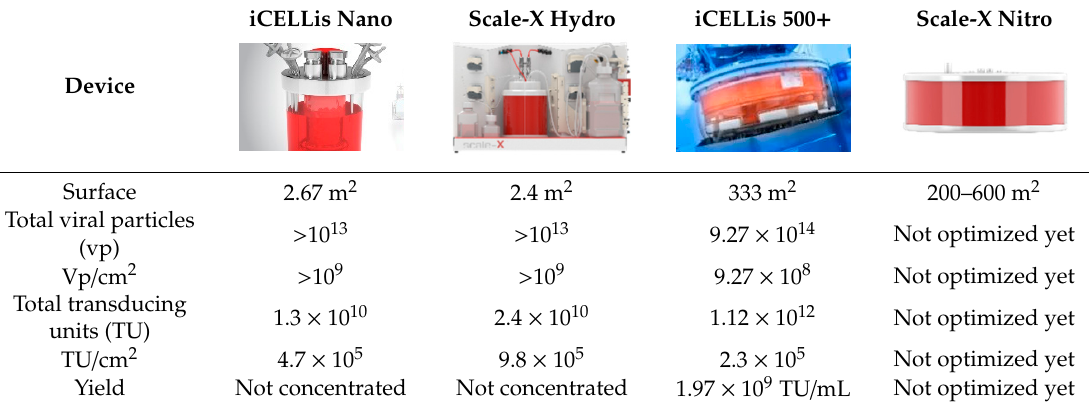
Table 3. Fixed-bed bioreactors optimized for high-scale LV production.